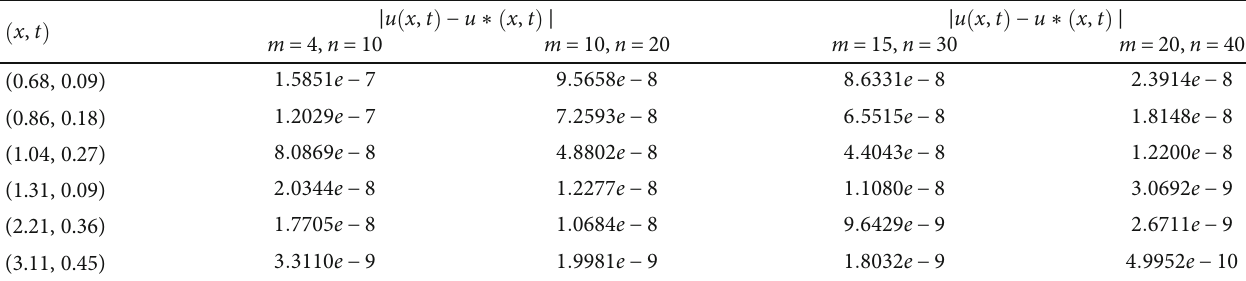
Table 5: Absolute error for di ff erent values of m , n for Example 9.